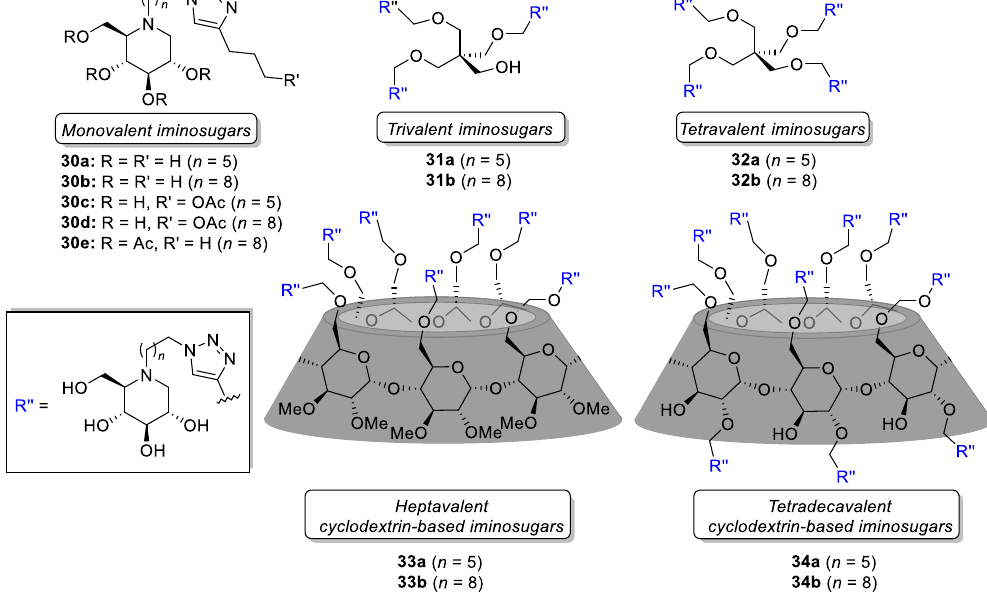
Figure 8. Multivalent iminosugars as F508del-CFTR correctors.